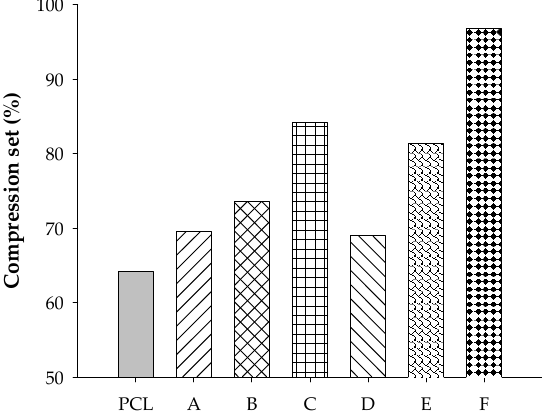
Figure 4. Compression set of PCL, A = STR5L/PCL at 40/60, B = STR5L/PCL at 50/50, C = STR5L/PCL at 60/40, D = ENR-50/PCL at 40/60, E = ENR-50/PCL at 50/50, and F = ENR-50/PCL at 60/40.